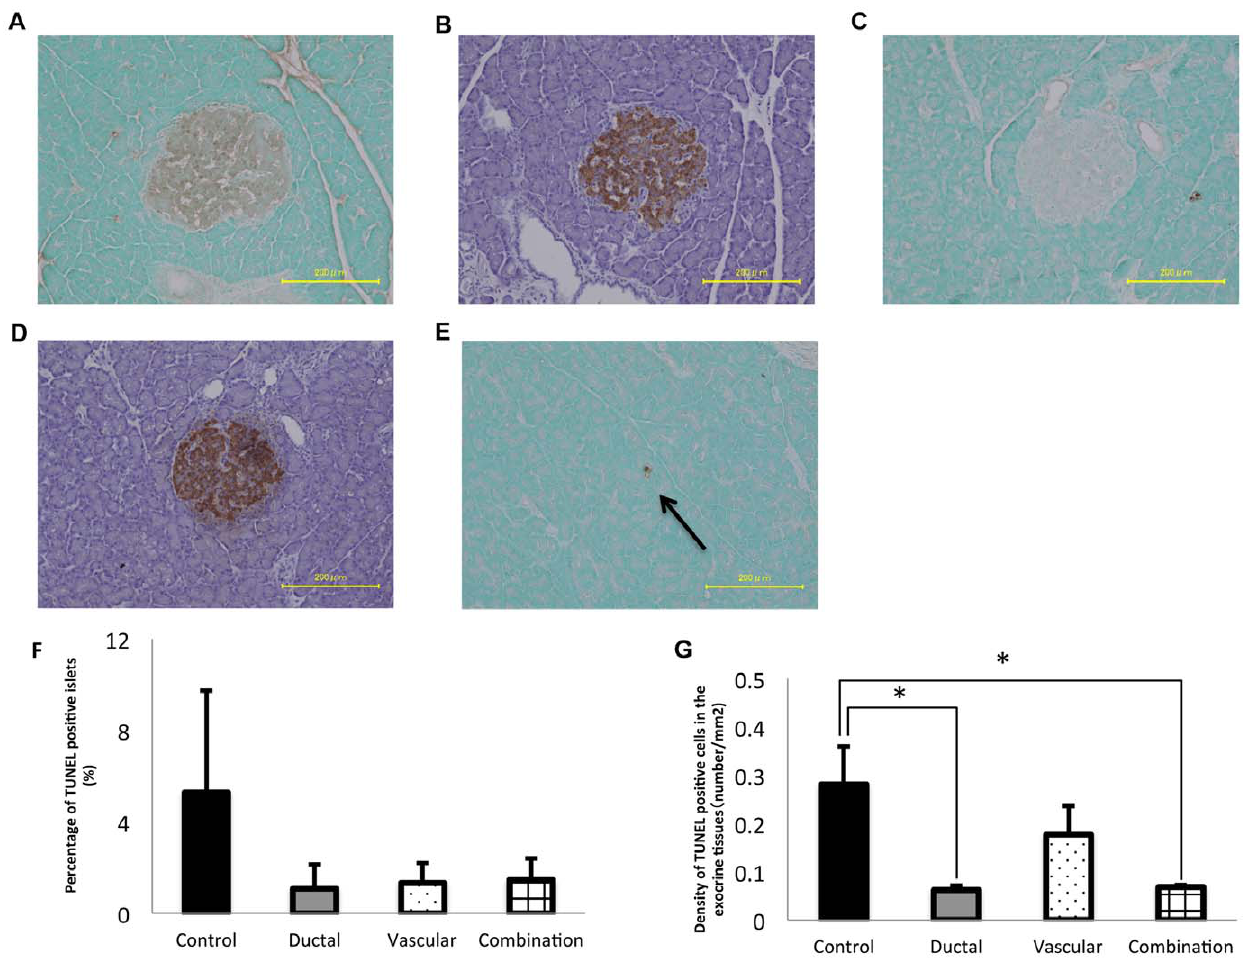
Figure 5. The TUNEL staining of the pancreatic islets and the exocrine tissues after cold storage. Representative of TUNEL positive islets (A), with insulin staining (B), and representative of TUNEL negative islets (C), with insulin staining (D) are shown. (E) The TUNEL positive cells in the exocrine tissues are shown (arrow). (F) The percentage of TUNEL positive islets (the number of TUNEL positive islets/the total number of islets *100) was calculated and evaluated. No significant differences were detected between groups. (G) The density of TUNEL positive cells in the exocrine tissues (the number of TUNEL positive cells/the total area of exocrine tissues in the sections) was calculated. The density of TUNEL positive cells in the ductal injection and combination groups was significantly lower than that of the control group. Magnification 6 200. The data are shown as the means 6 SE. * P , 0.05.